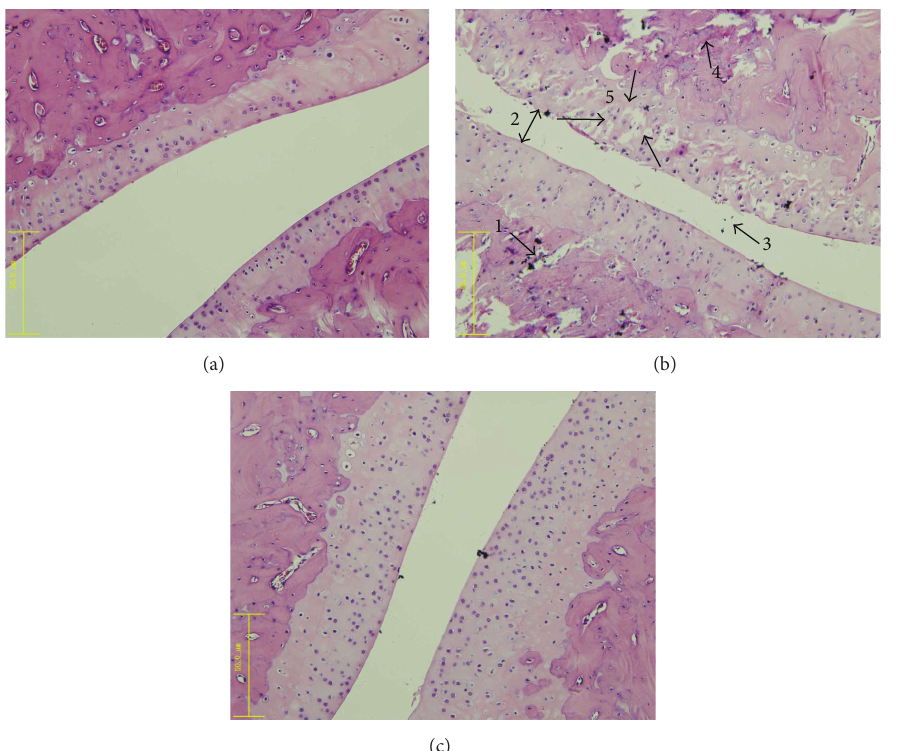
Figure 1: Effects of XFC on histopathologic changes of the AA rats. Photomicrographs of representative histopathologic specimens of left hind joints in SD rats taken from healthy group (a), untreated group (b), and XFC treated group (c). 1: inflammatory cell infiltration; 2: joint-space narrowing; 3: neutrophils infiltration; 4: pannus formation; 5: cartilage erosion. Original magnification 400x.